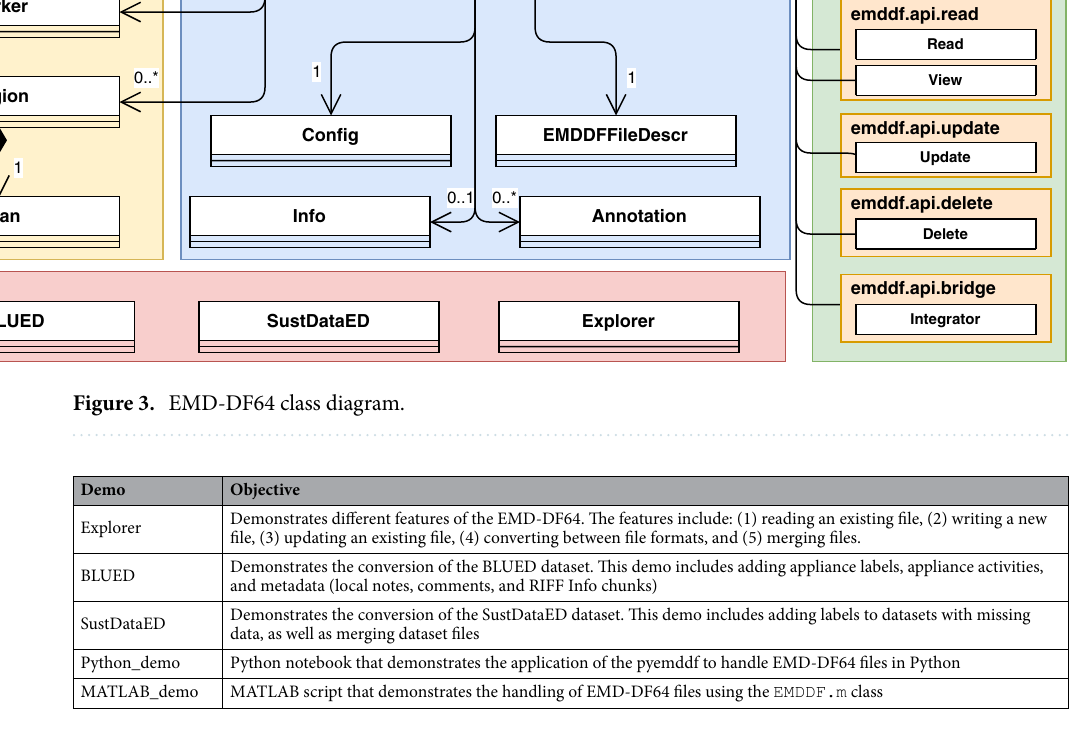
Table 4. Description of the demos provided along the the EMD-DF64 software